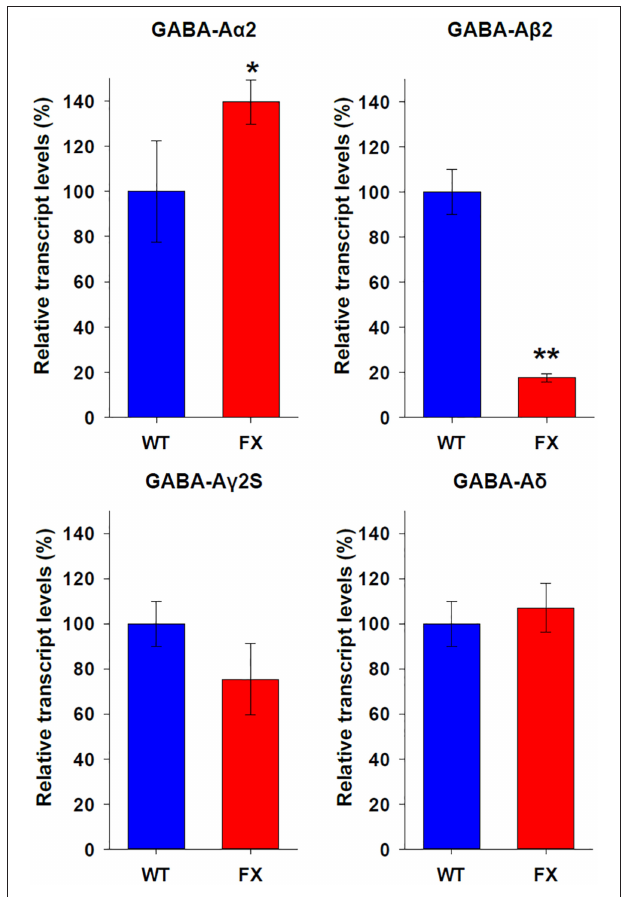
FIGURE 4 | Expression of GABA-A receptor subunits in WT and FX neurons. Quantitative Real Time PCR analysis of relative transcript levels for the GABA-A receptor subunits: α 2 , β 2 , γ 2S , and δ . Analysis was conducted on RNA isolated from age 120 to 130 days WT (blue) neurons in 2 different experiments, and from all three FX lines (red) in one experiment for each line; in triplicates. Values were normalized to GAPDH ( 11 Ct) and are shown as mean ± SEM (% of control). * p < 0.05 ; ** p < 0.01 ; t- test.